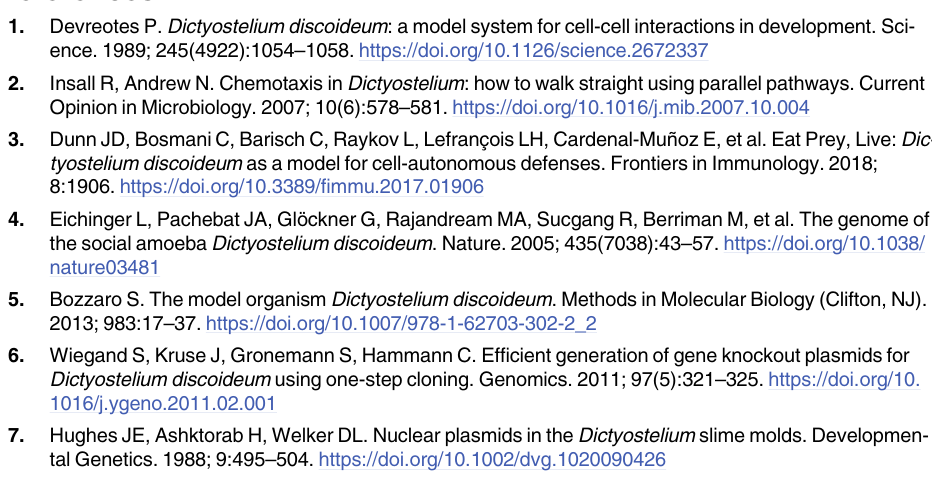
S22 Fig. Flow cytometry data of NC28.1 cells transfected with the P2A plasmid and selected with 600 μ g/ml hygromycin. Top: Forward scatter and side scatter profiles of all three replicates. Events inside the polygon were considered live cells. Middle: Green fluores- cence values for live cells for each replicate. Displayed numbers indicate the total event count and the percentage of events below or above the threshold. Cells above the fluorescence thresh- old were retained for further analysis. Bottom: Mean fluorescence values for each replicate. (TIFF) S23 Fig. Flow cytometry data of NC28.1 cells transfected with the P2A plasmid and selected with 800 μ g/ml hygromycin. Top: Forward scatter and side scatter profiles of all three replicates. Events inside the polygon were considered live cells. Middle: Green fluores- cence values for live cells for each replicate. Displayed numbers indicate the total event count and the percentage of events below or above the threshold. Cells above the fluorescence thresh- old were retained for further analysis. Bottom: Mean fluorescence values for each replicate.